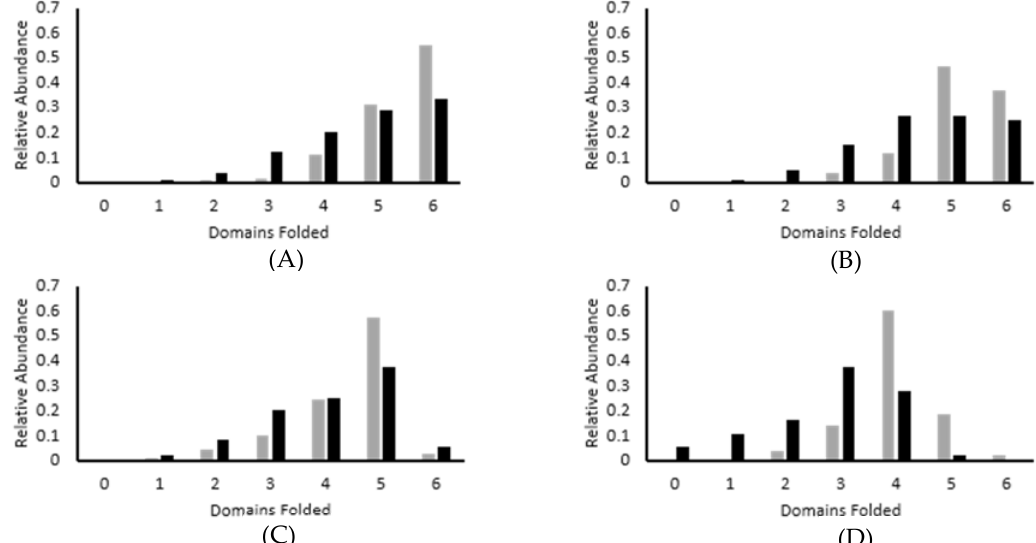
Figure 4. Sample refolding traces of (I83) 6 polymer in calcium shifts equilibrium to folded state. The same molecule was monitored in absence (black) and presence (gray) of calcium. A histogram is used to show the distribution of the number of folded domains as measured by extension values over 60 s. A shift toward the folded state is observed in the presence of calcium at ( A ) 4 pN, ( B ) 6 pN, ( C ) 8 pN, and ( D ) 10 pN.